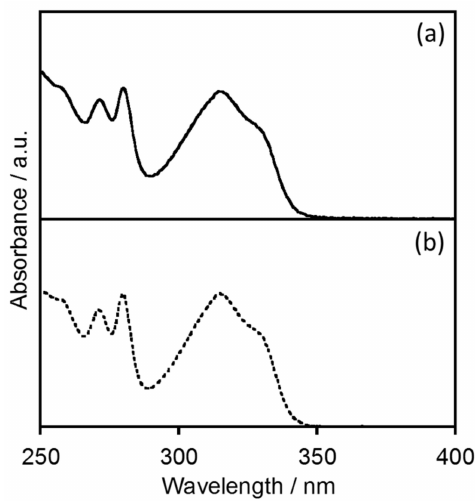
Figure 2. Electronic absorption spectra of the helical Eu complex with L ( a ) in [BMIM][PF 6 ] compared with ( b ) in acetonitrile [4].